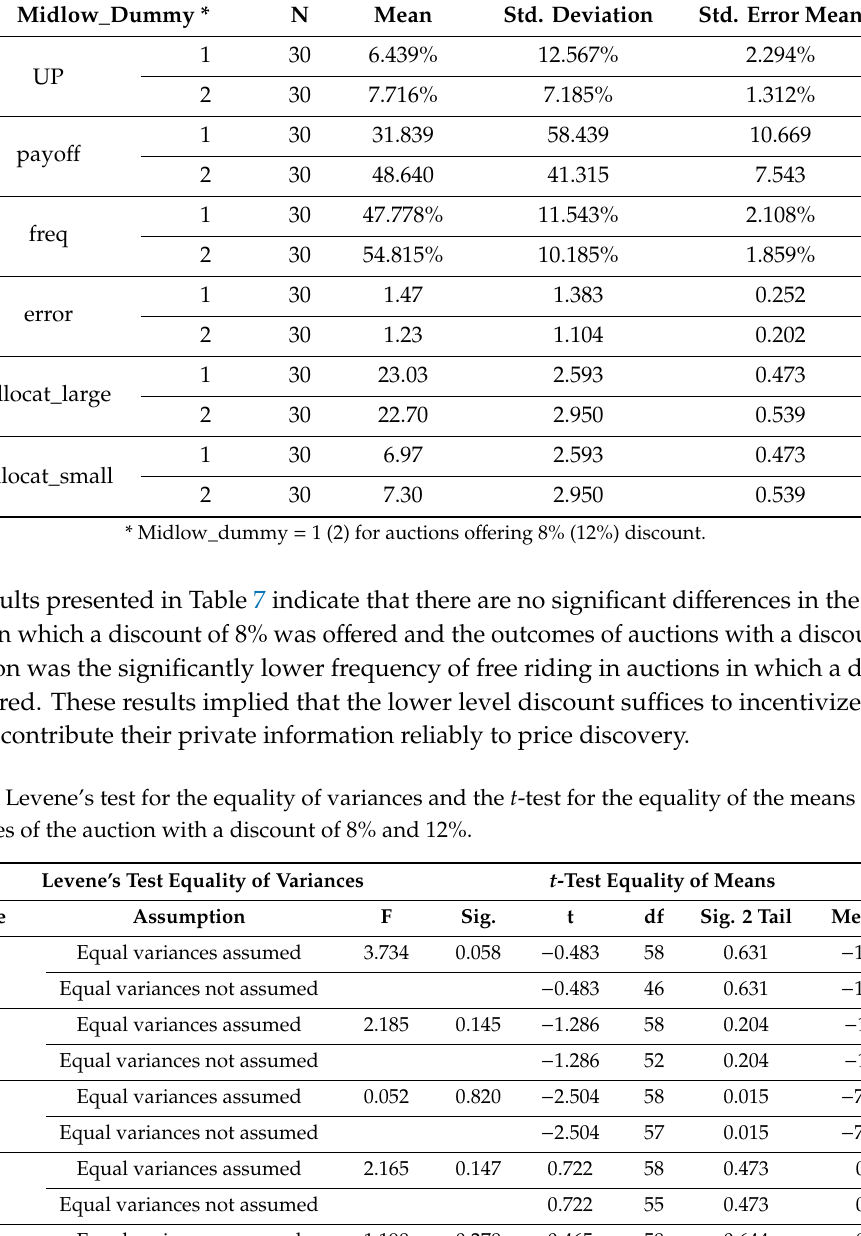
Table 6. Outcomes of auctions in which the investors are o ff ered a discount of 8% or 12%. Midlow_Dummy * N Mean Std. Deviation